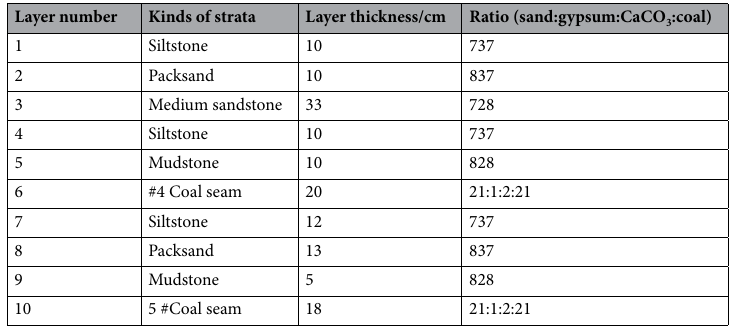
Table 4. Ratio of physical similar material simulation test. Note: 737 proportion number. The first number 7 indicates that the sand binder ratio is 7:1, and the second and third numbers 3 and 7 indicate that the ratio of gypsum to large lime is 3:7.